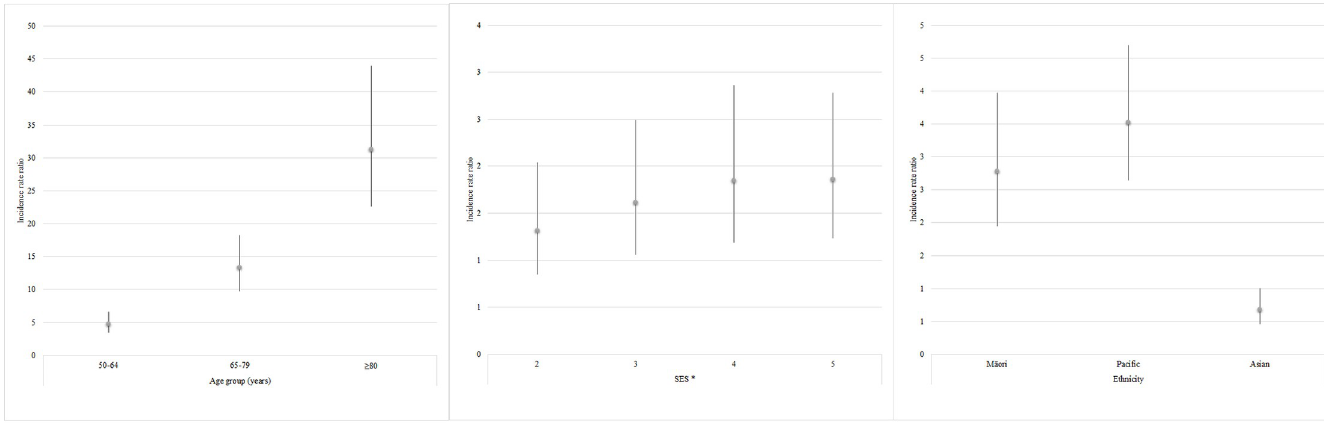
Fig 4. Adjusted incidence rate ratios for age group (referent 18–49 years old), socio-economic status (referent–quintile 1), and ethnicity (referent–European/ other) of respiratory syncytial virus (RSV) associated acute respiratory infection (ARI) hospitalizations among adults 50 years or older in Auckland, New Zealand, 2012–2015. � Incidence rate ratios for age, socio-economic status and ethnicity have been adjusted for each other. † SES quantified using a small area level measure of neighborhood deprivation derived from the national census (NZDep2013) with SES 1 as least deprived and SES 5 as most deprived [22].